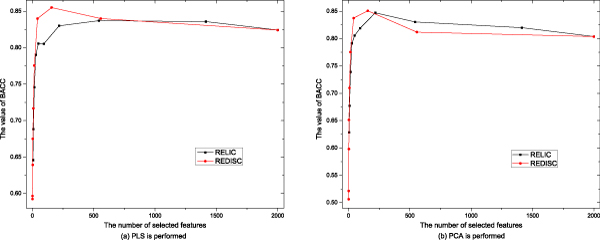
Comparative results of BACC scores by using different algorithms on the Colon data set.